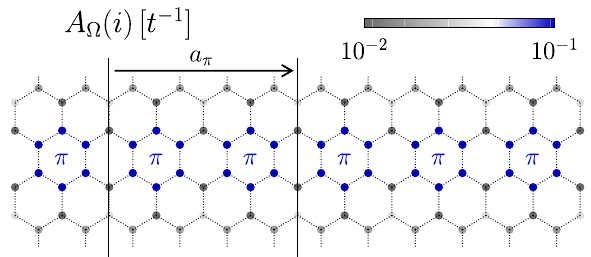
FIG. 9. Integrated local density of states A (cid:2) ð i Þ ( (cid:2) ¼ 0 : 2 t ; see text) at T ¼ 0 for the Kane-Mele model ( (cid:4)=t ¼ 0 : 2 , (cid:5) ¼ 0 ) with a periodic chain of (cid:1) fluxes. We show a part of the 72 (cid:4) 12 lattice used and the size of the magnetic unit cell containing two ¼ 4 a , where a (cid:10) 1 corre- (cid:1) fluxes. The latter has width a (cid:1) sponds to the norm of the lattice vectors of the underlying honeycomb lattice.